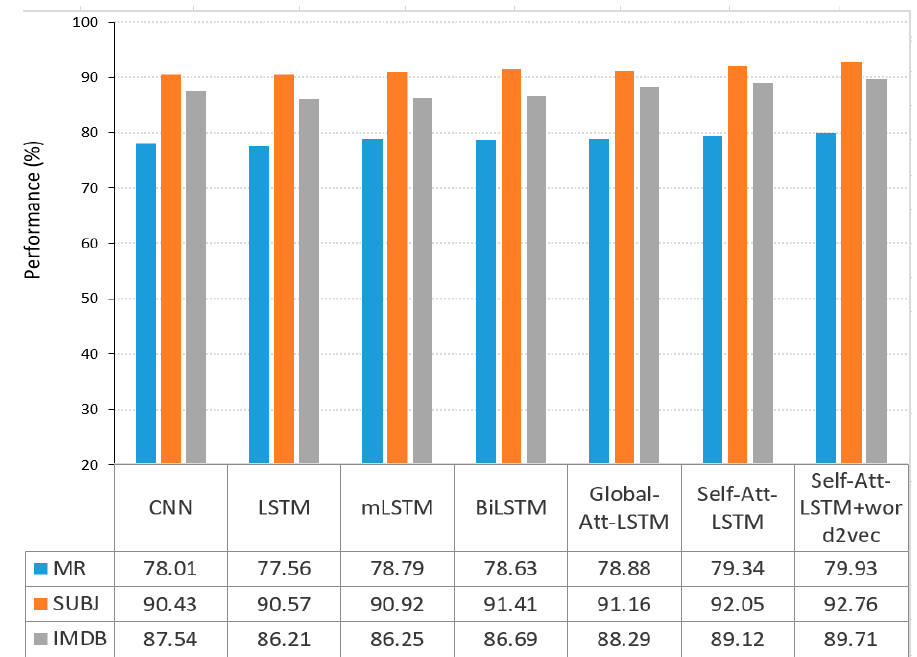
Figure 5. Performance of the models on the SUBJ, MR and IMDB